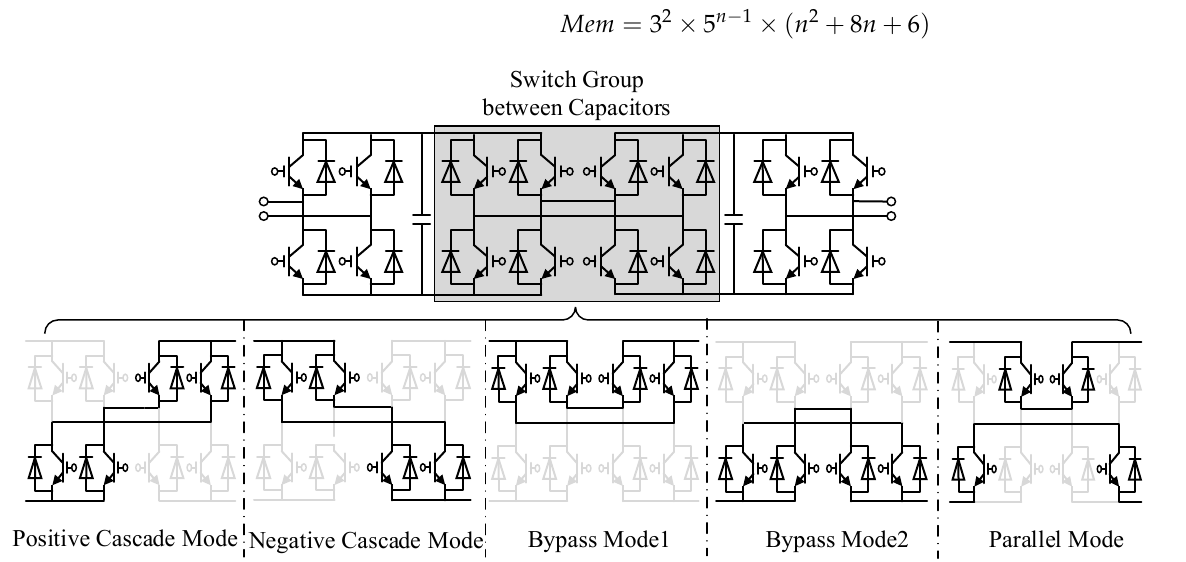
Figure 6. Connection (mode) of adjacent submodules. The number of prestored parameters exponentially increases as the number of sub ‐